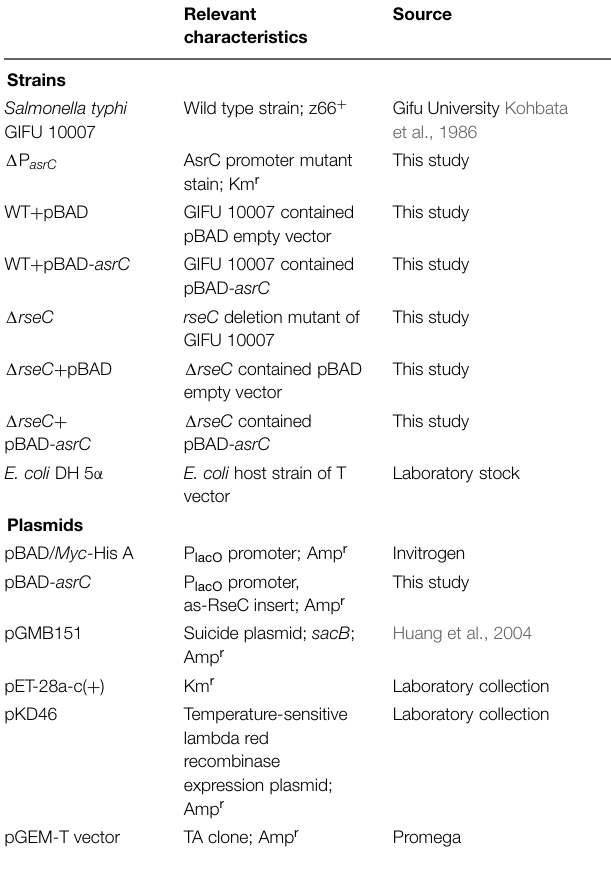
TABLE 1 | Bacterial strains and plasmids used in this